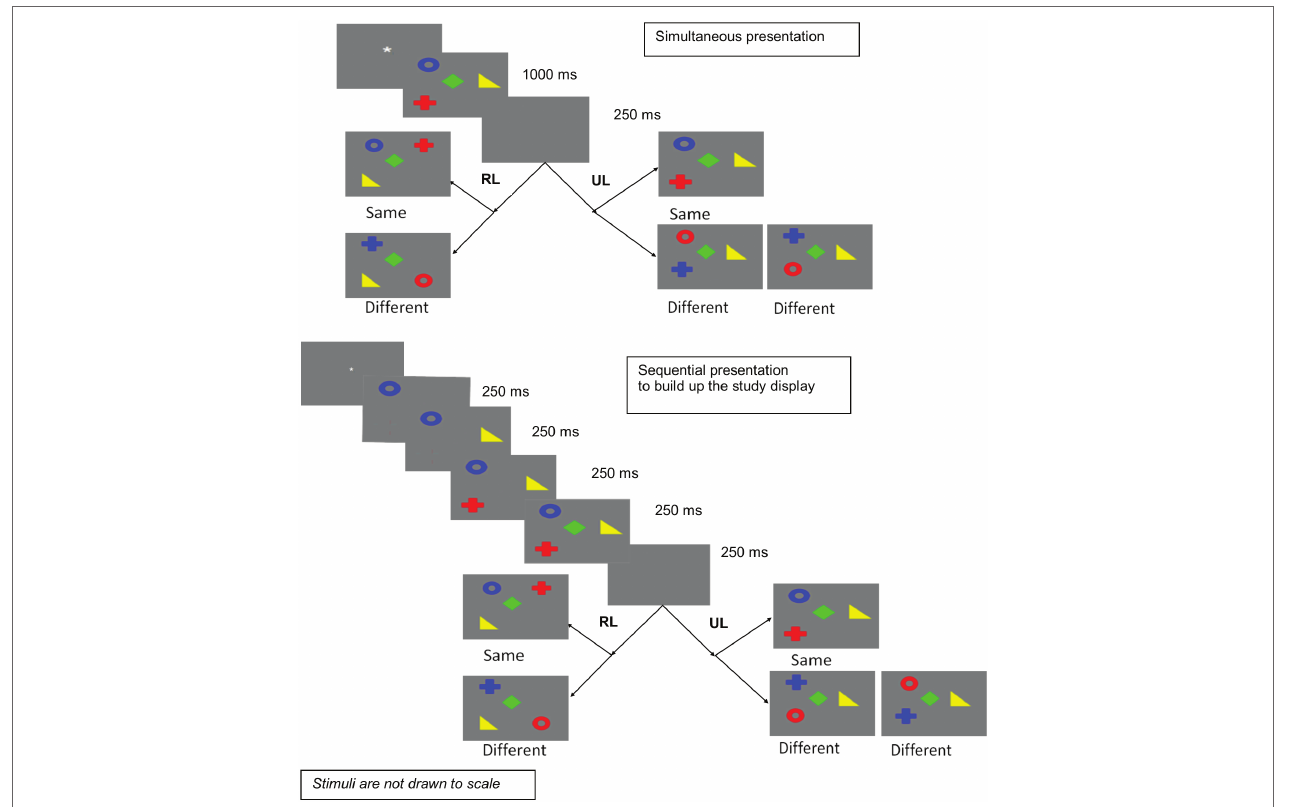
FIGURE 1 | Simultaneous and sequential presentations in Experiment 1 (RL, random locations; UL, unchanged